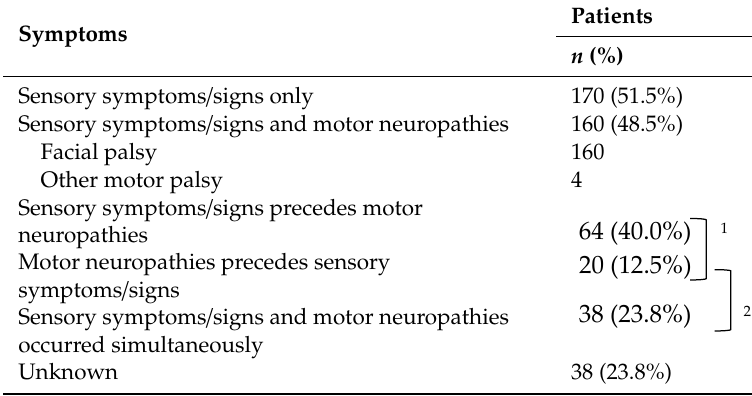
Table 3. The involvements of cranial sensory symptoms / signs and motor neuropathies in patients with herpes zoster infection.